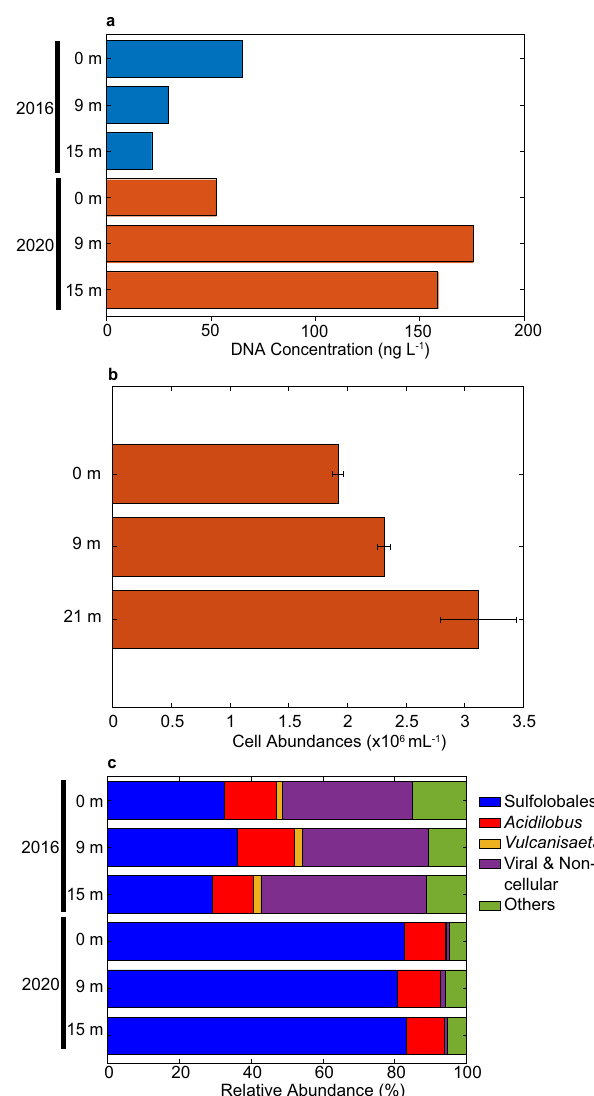
Fig. 3 Characterization of Cinder Pool (CP) planktonic communities in depth-resolved samples taken in 2016 and 2020. a Total DNA extracted from biomass fi ltered from CP waters obtained from 0, 9, and 15 m, normalized to liters of water fi ltered. b Abundances of cells in waters collected from 0, 9, and 21 m depth of CP in 2021. Cellular abundances were not enumerated in 2016 water samples. Error bars show standard deviations from triplicate measurements. c Composition of CP water communities sampled from 0, 9, and 15 m. The relative abundance of taxonomic orders was evaluated based on the percentage of quality- fi ltered metagenomic reads mapped to each metagenome-assembled-genome (MAG) shown in the legend on the upper right. Viral and non-cellular reads are those that were assigned as a viral contig or were otherwise not clearly associated with cellular genomes. ‘ Others ’ comprise the remaining reads. Only the most abundant unbinned contigs that comprised 75% of all reads mapped to unbinned contigs were evaluated for viral/non-cellular assignment (Supplementary Data